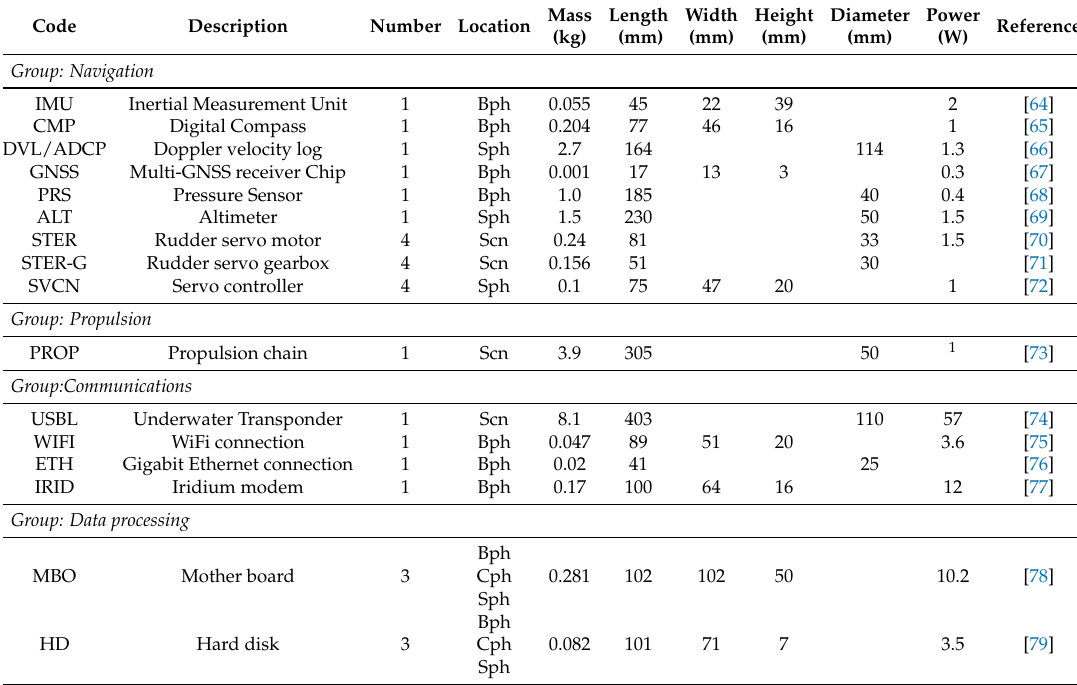
Table A2. Auxiliary equipment characteristics. Bph, bow pressure hull. Cph, central pressure hull. Sph, stern pressure hull. Scn, stern